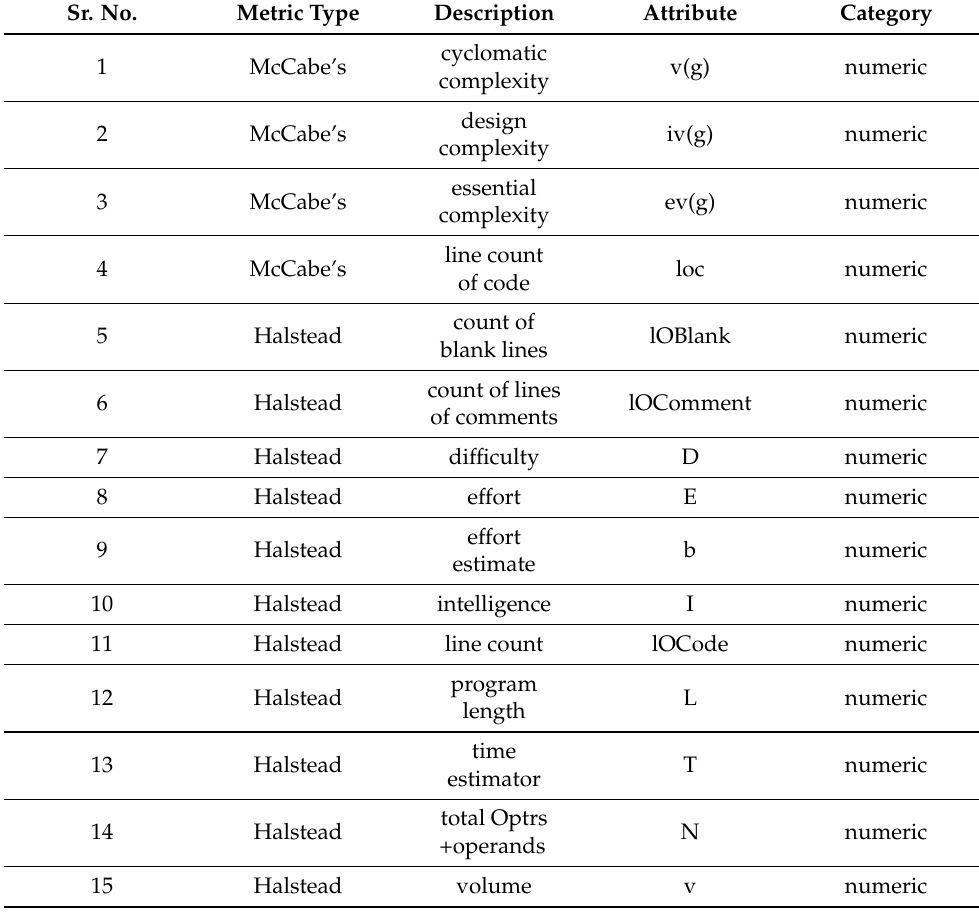
Table 2. Attribute details of the NASA datasets. Sr.